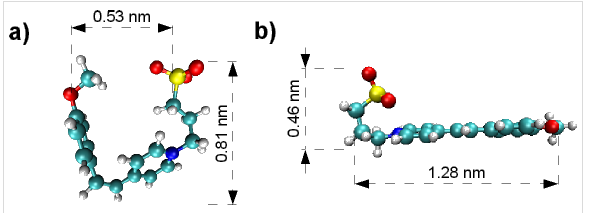
Figure 1: MSPS can have two conformations, namely the agraffe-like cis (a) and the scorpion-like trans (b) isomerization.